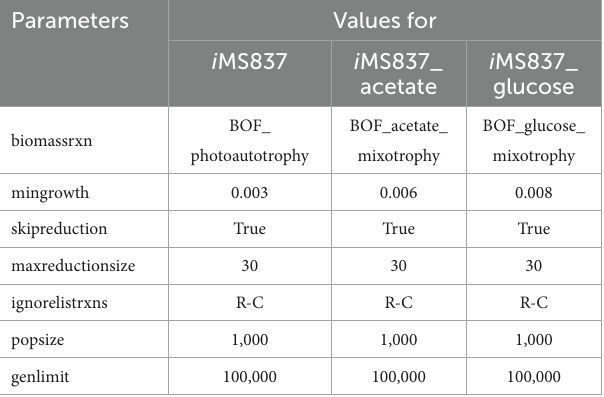
TABLE 3 List of parameters used with gcFront